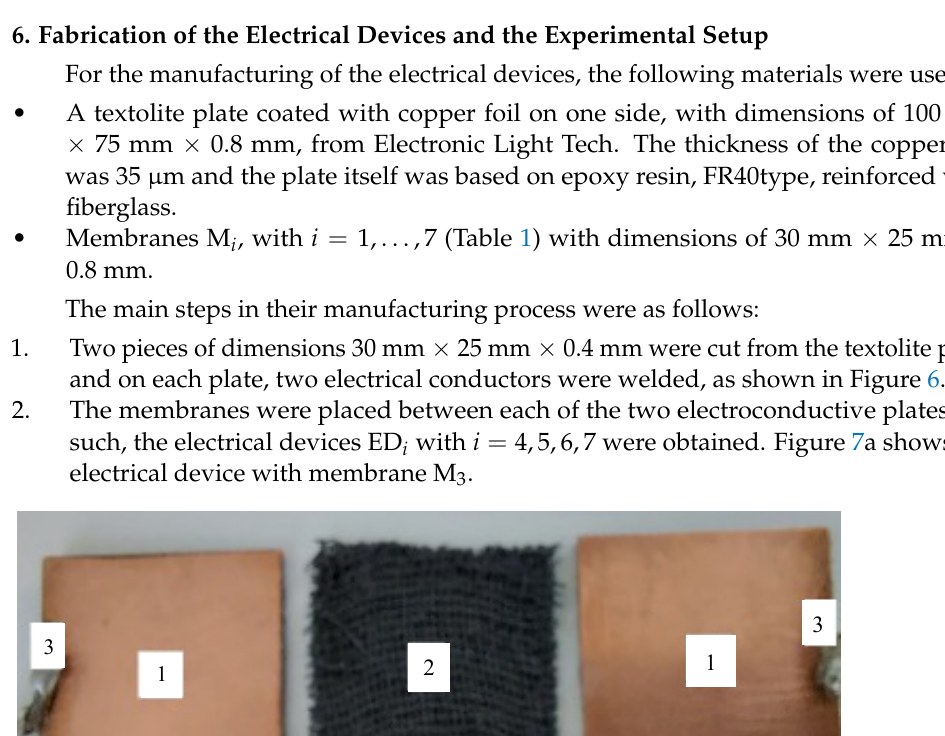
Figure 5. Magnetization curves for the CI microparticles ( a ) and the magnetizable CMs ( b ). σ is the relative magnetization and H is the magnetic field intensity.